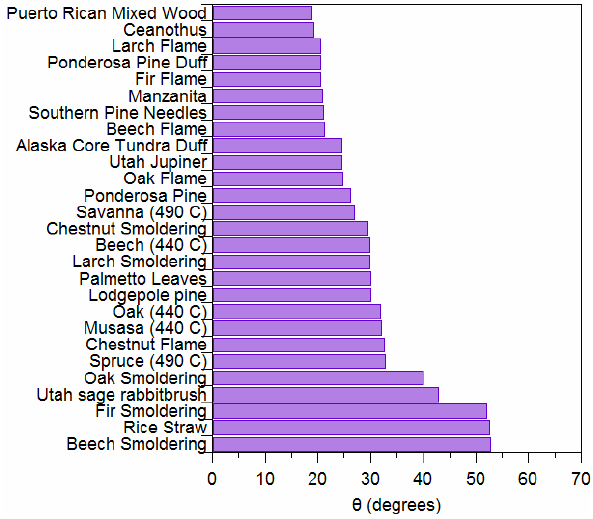
Figure 4. Contribution of m/z 60 ( f 60 ), levoglucosan tracer, to the various BBOA mass spectra. The f 60 in the olive tree branches burning mass spectrum is only 0.6%.